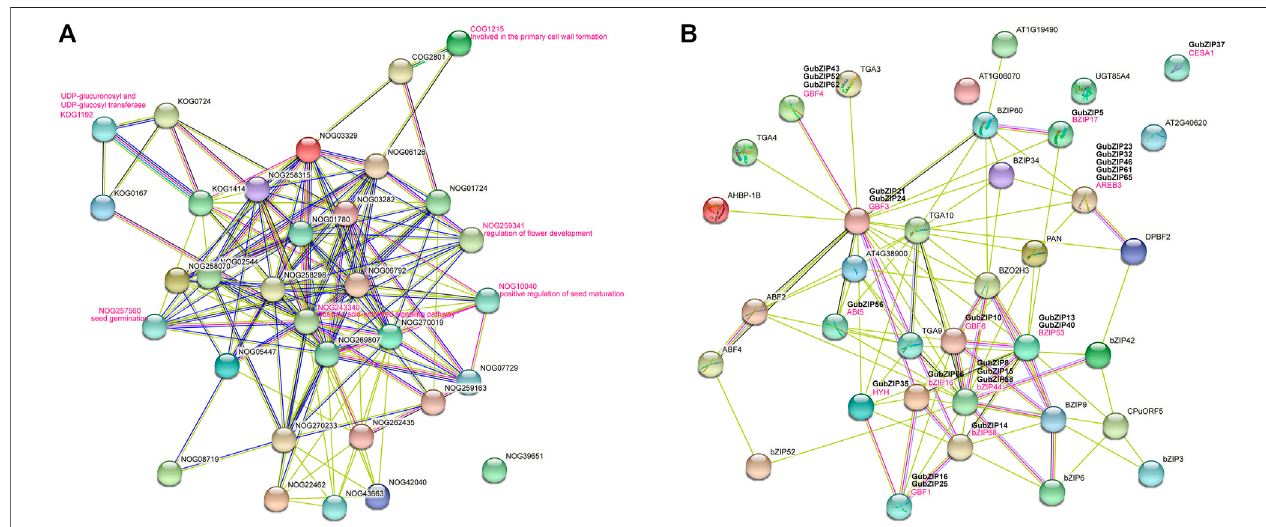
FIGURE 5 | Interaction network of GubZIP proteins. (A) Search for the orthologs in Arabidopsis matching GubZIPs. (B) The GubZIP protein – protein interaction network.ThisnetworkwaspredictedbyonlinesoftwareSTRING.TheGubZIPproteinsrelatedtoabioticstressesareshownintheboldblackfontabovethe Arabidopsis orthologs.